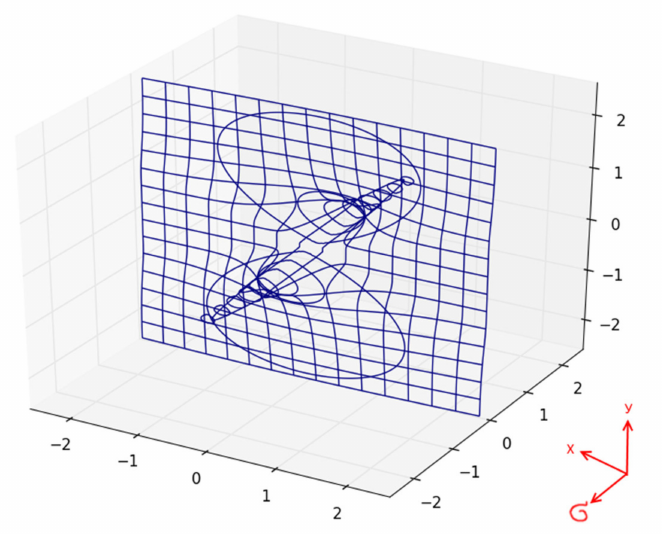
Figure 8. Hodograph of the Gaussian distribution density of the normalized random variable y = ϕ (u).